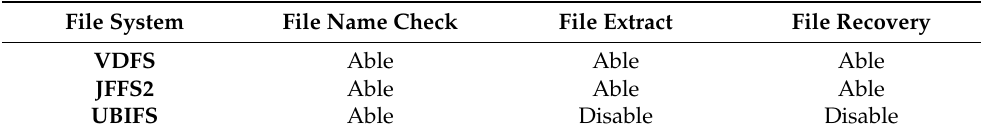
Table 1. The possibility of information available for each file system.